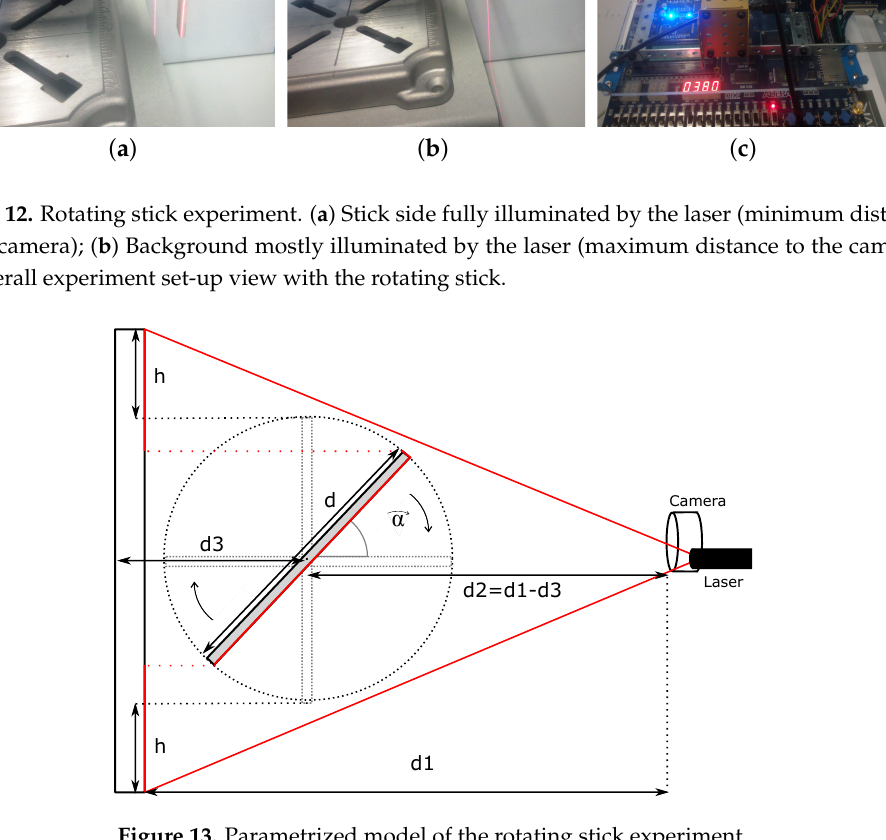
Figure 13. Parametrized model of the rotating stick